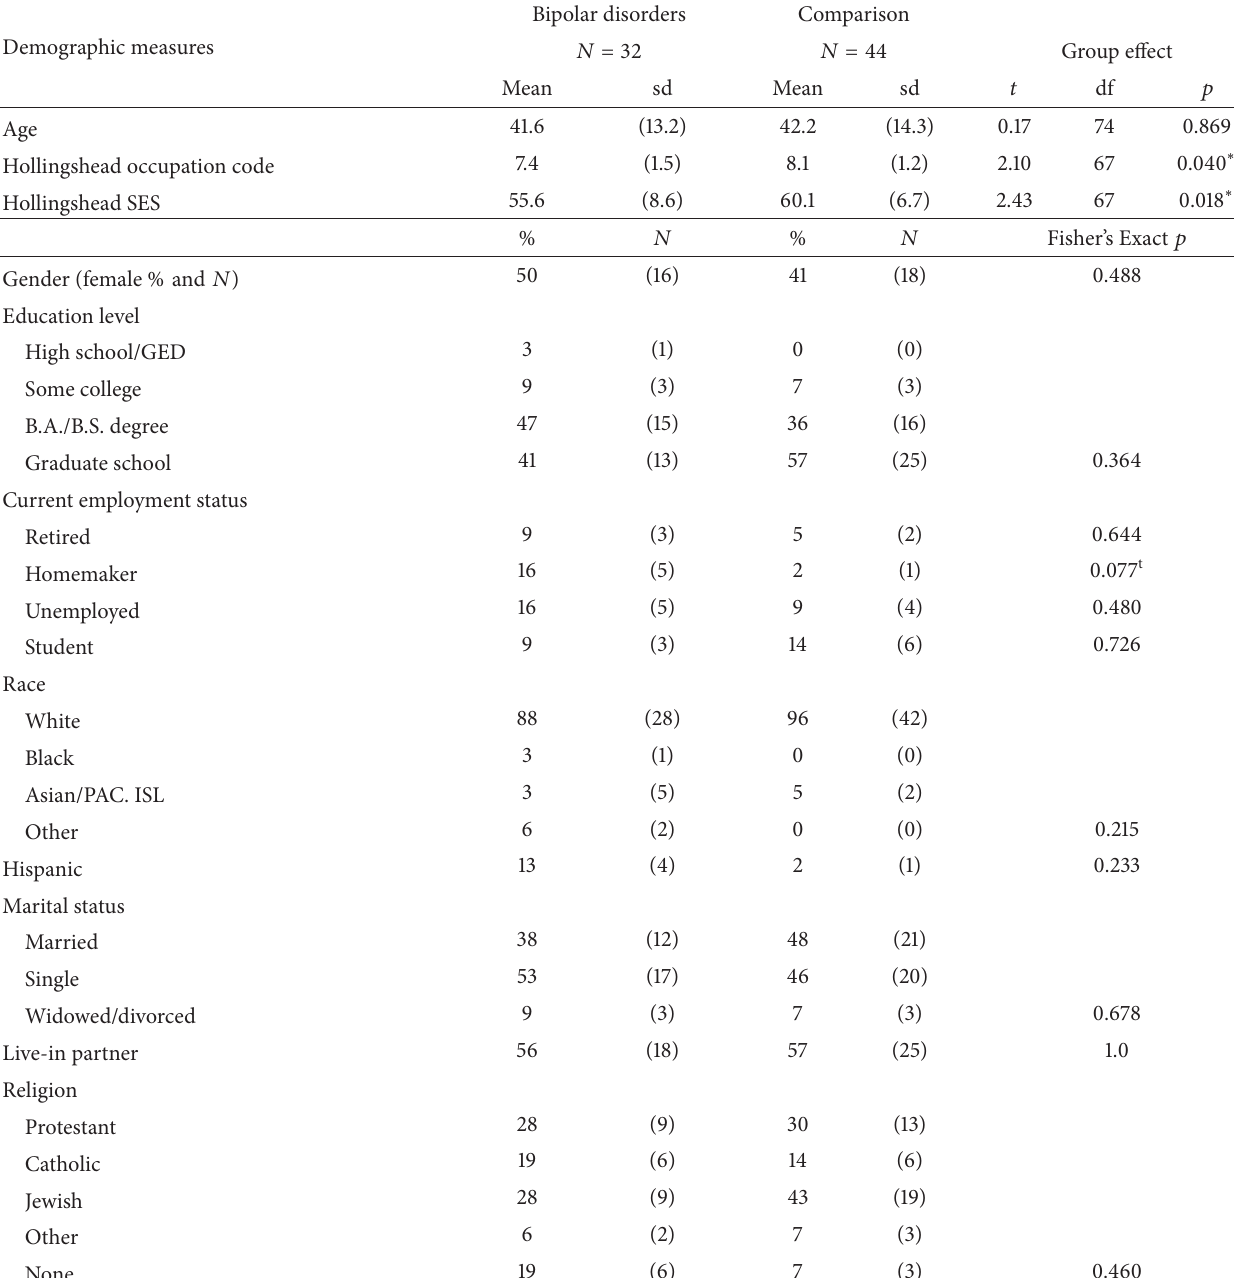
Table 1: Demographics: statistics are the 𝑡 -test for continuous measures and the Fisher’s Exact Test for categorical